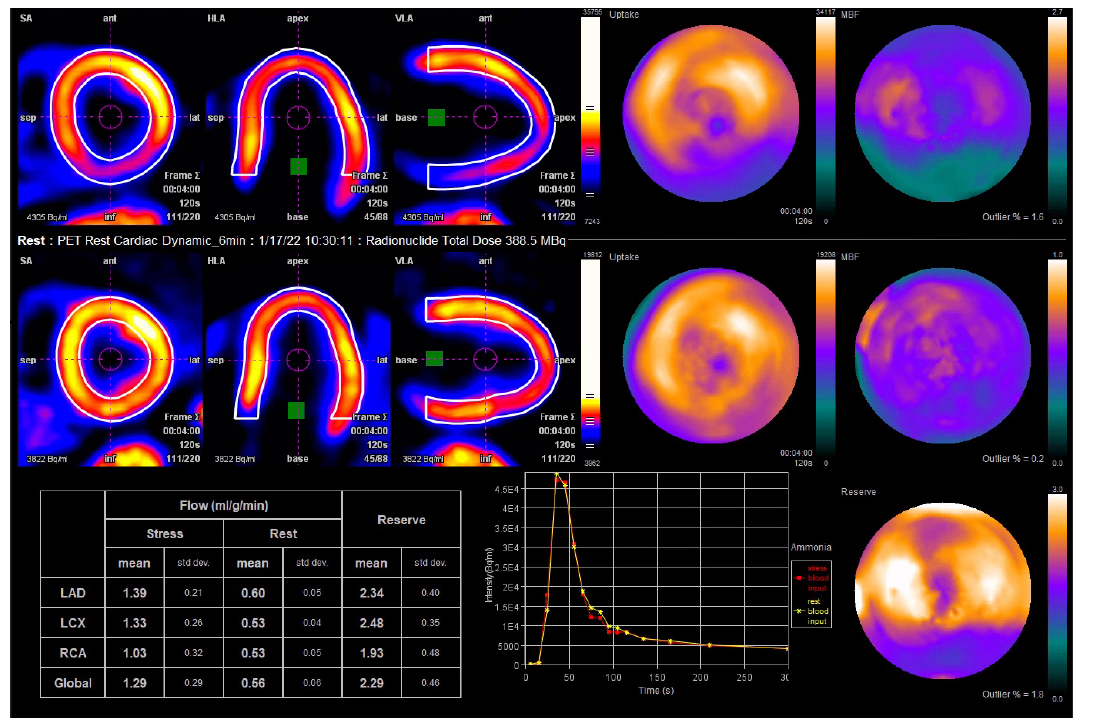
Figure 3. Quantitative assessment of myocardial perfusion with 13N-ammonia-PET of the same pa- tient represented in Figure 2. Note that myocardial flow during stress is decreased in the RCA ter- ritory. LAD—left anterior descending artery, LCX—left circumflex artery; RCA—right coronary ar- tery. Image source: Institute for Nuclear Sciences Applied to Health